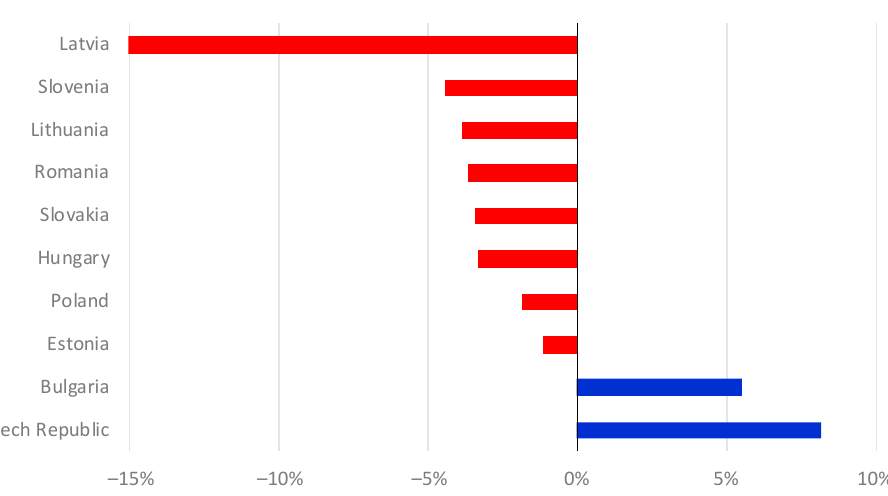
Figure 2. Total changes in energy consumption in households in CEE countries in 2008–2018. At the same time, the CEE countries with the highest energy consumption in house- holds per capita include Estonia, the Czech Republic, and Lithuania, where in 2018 it was at a level exceeding 600 thousand tons (in oil equivalent—TOE) [113,114]—see Figure 3. The smallest consumption, on the other hand, was characteristic of Bulgaria, Slovakia, and Romania, where it did not exceed 400 thousand tons of energy per capita.